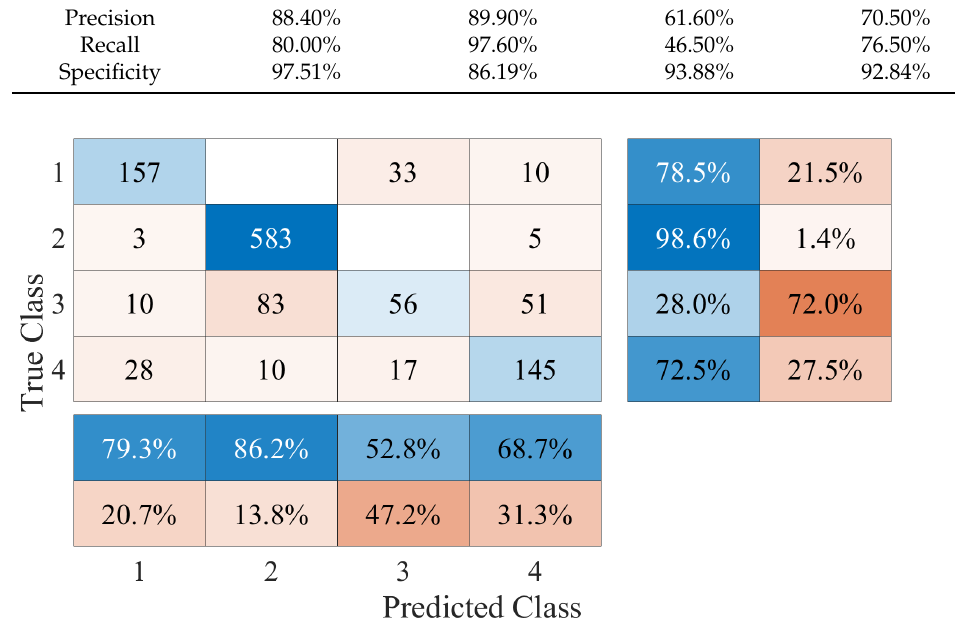
Figure 10. CNN multi-class classification confusion matrix results, where the classes correspond to (1) no activity, (2) walking, (3) going up/down stairs, and (4) falling. Table 4. Results of the metrics computed from the confusion matrices in the CNN